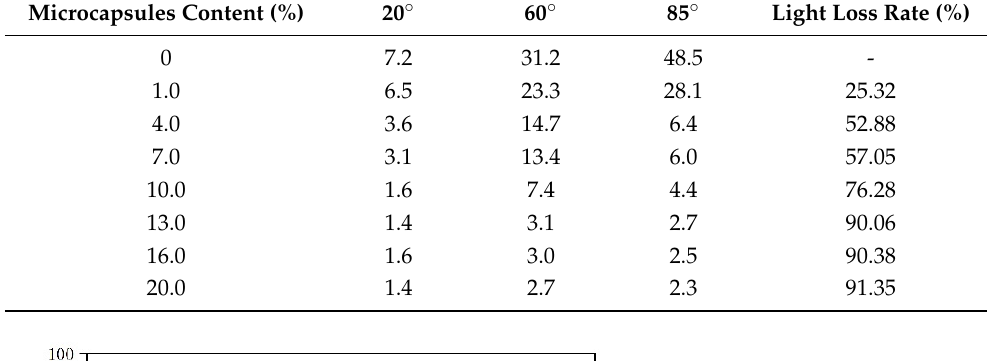
Table 5. Gloss of the coatings with different microcapsule content.